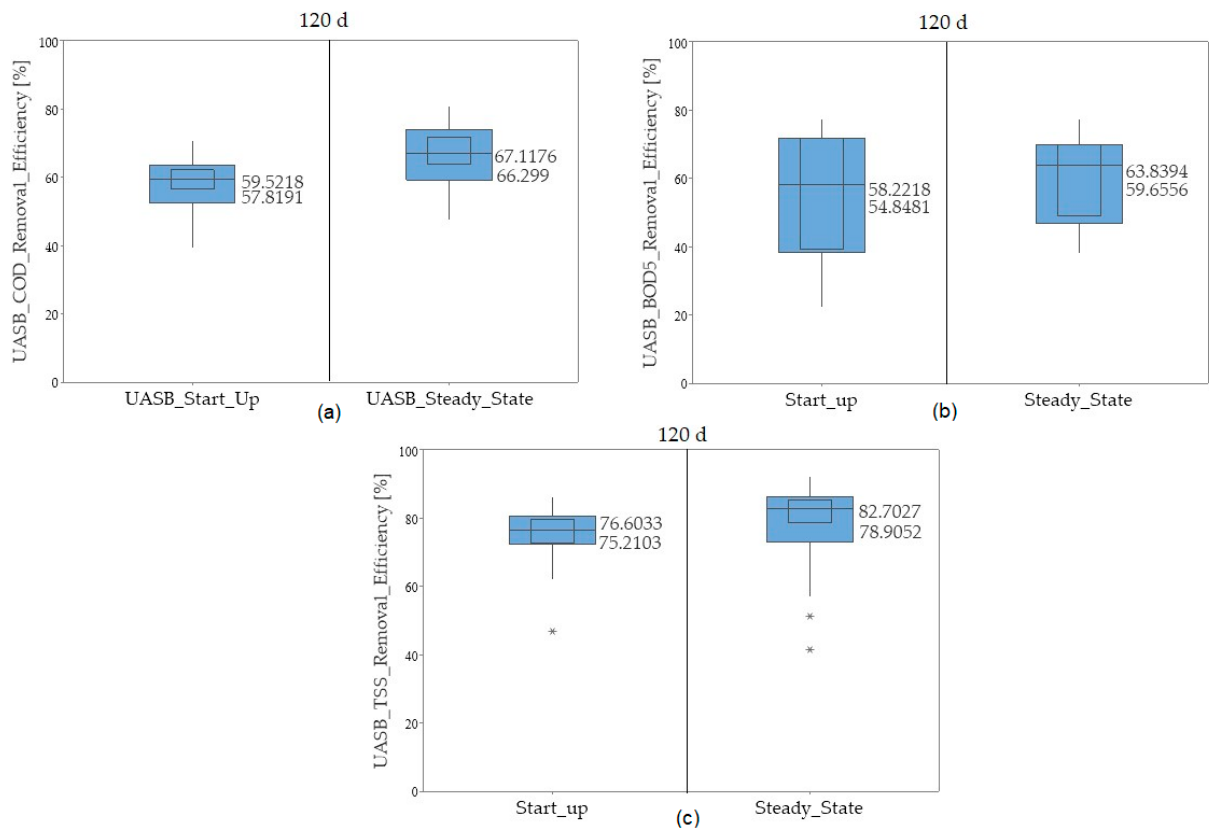
Figure 6. Removal efficiencies in the UASB reactor during the start-up and steady state: ( a ) COD, ( b ) BOD, and ( c ) TSS. ∗: boxplot outlier